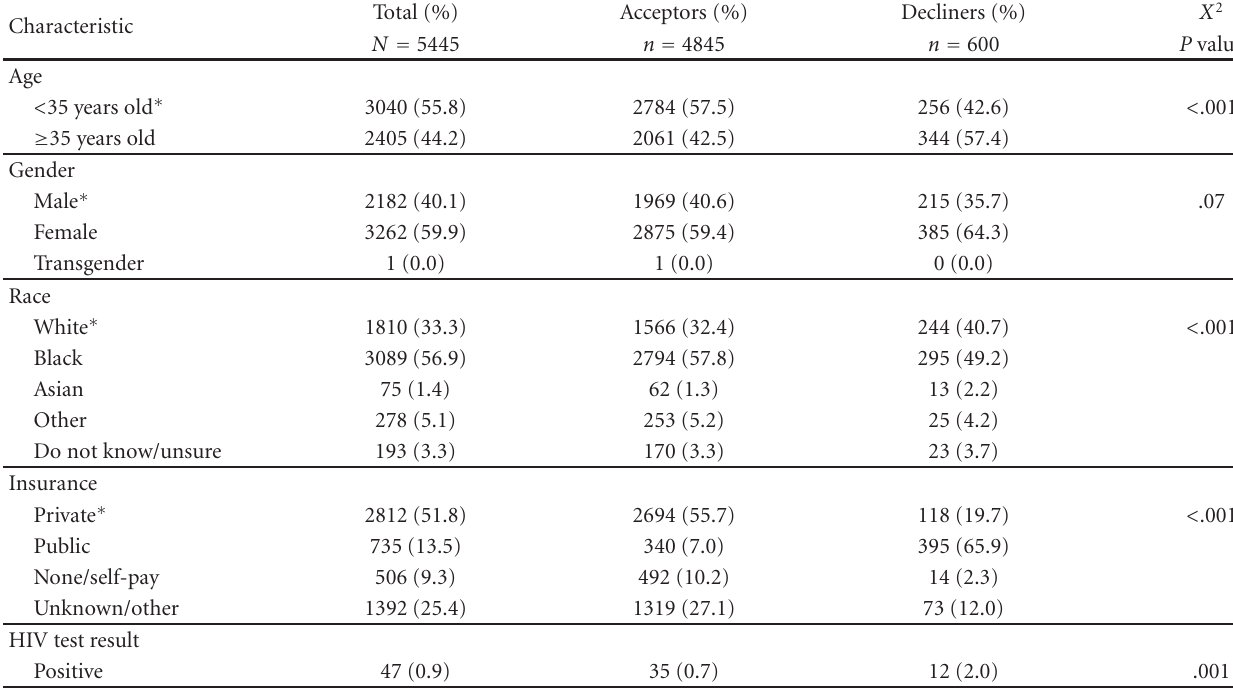
∗ Comparison used to determine P value.